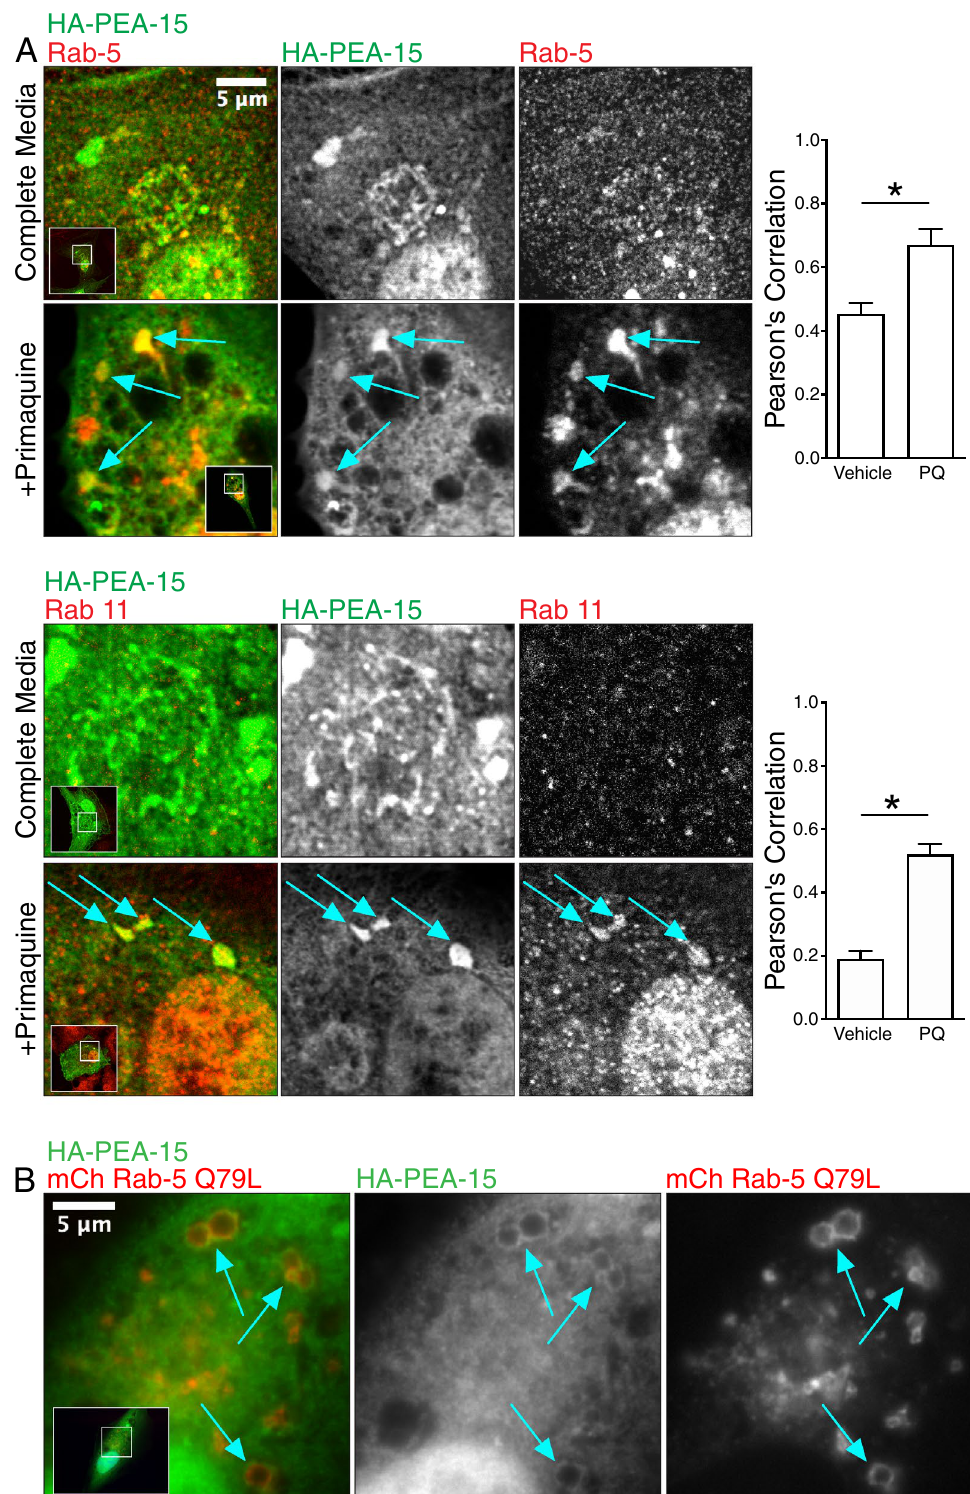
Figure 4. PEA-15 traffics to Rab5 endosomes. ( A ) HA-tagged PEA-15 was expressed in U87MG cells that were treated with primaquine or control. Cells were then fixed with paraformaldehyde and immunostained for PEA- 15, Rab5 or the recycling endosome marker Rab11. Co-localization between PEA-15 and endosomal markers was measured by quantitation of the Pearson correlation using ImageJ software (* p < 0.005, n = 11 for each pairing). Enlarged vesicles co-staining for both HA-tagged PEA-15 and endosomal markers are indicated by arrows. Scale bar = 5 µm. ( B ) HA-tagged PEA-15 and mCherry-tagged Rab5 Q79L mutant were overexpressed in U87MG cells and immunostained with anti-HA antibodies for PEA-15. Co-localization of HA-PEA-15 and mCherry Rab5 Q79L occurred on ringed structures (arrows). Scale bar = 5